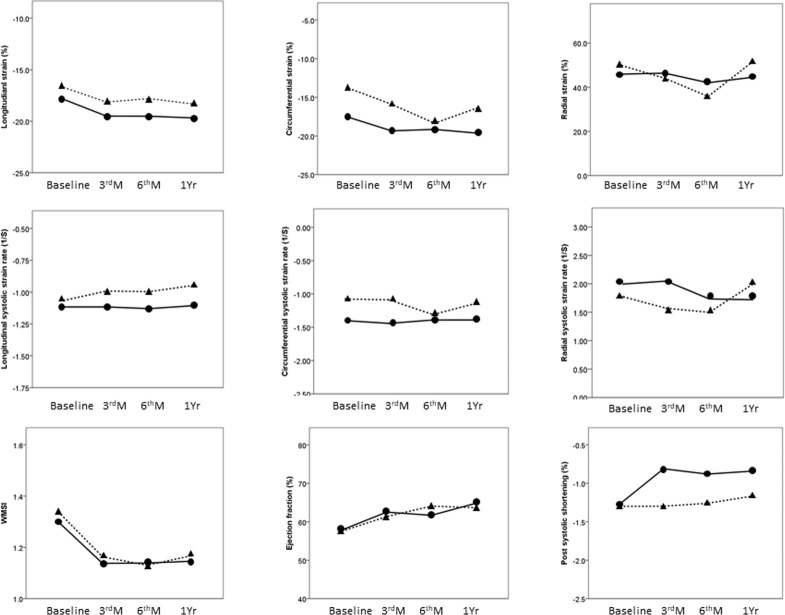
The serial changes between patients with (dotted line) and without (solid line) symptom-driven infarct related artery revascularization.